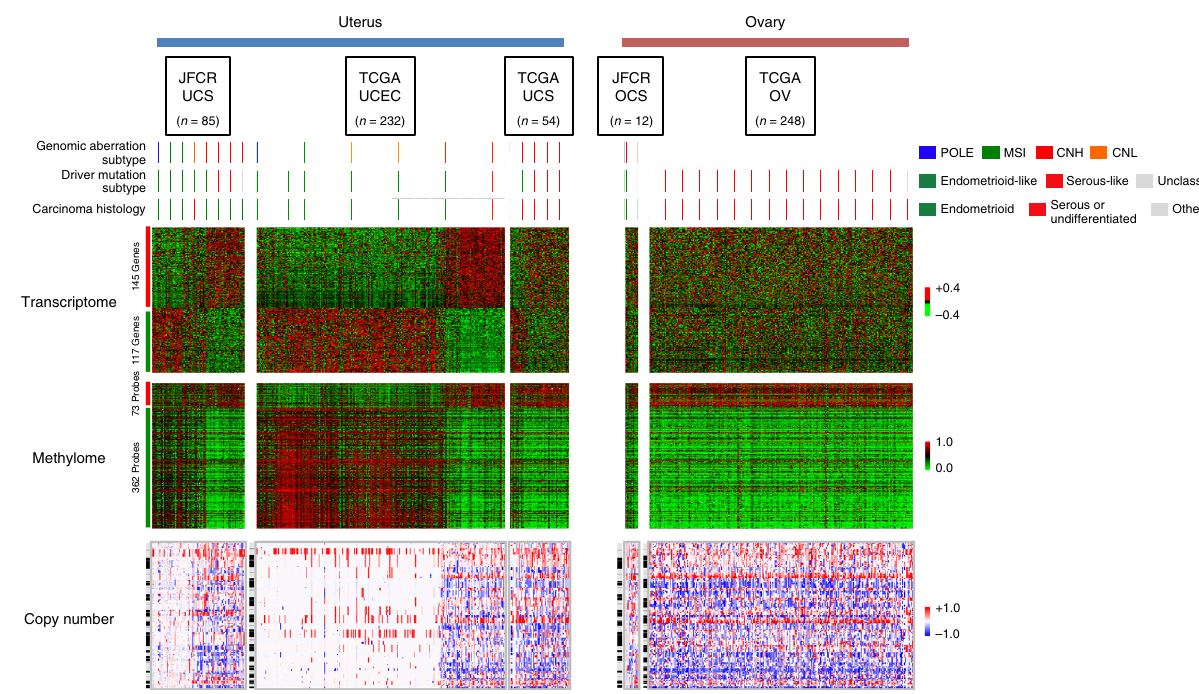
Fig. 4 Genomic aberration subtypes in the transcriptome, DNA methylome, and copy number data derived from uterine and ovarian cancers. Heatmaps for gene expression (upper panel; red and green color indicate high and low expression), CpG methylation (middle panel; red and green color indicate hyper- and hypo- methylation of the CpG site) and aberrant copy number segments (lower panel; red and blue color indicate gain and loss of segments in copy number) are shown. For the transcriptome or DNA methylome, serous (red line) vs. endometrioid (green line) signatures were generated using the uterine corpus endometrial carcinoma datasets in The Cancer Genome Atlas repository (TCGA UCEC n = 232) and applied to uterine and ovarian carcinosarcoma (UCS and OCS) datasets from the JFCR (Japanese Foundation for Cancer Research), TCGA (JFCR UCS n = 85, TCGA UCS n = 54, and JFCR OCS n = 12), and from TCGA high-grade serous ovarian cancer (TCGA OV n = 248). Data are presented as heatmaps. The serous vs. endometrioid signatures consisted of 145 and 117 genes for the transcriptome and 73 and 362 probes for the DNA methylome. For copy number data, the heatmaps show abnormal segments detected by EXCAVATOR and GISTIC in chromosomal order. Genomic aberration subtypes (POLE, blue; MSI, green; CNH, red; and CNL, orange), driver mutation subtypes (endometrioid-like, green; serous-like, red; and unclassi fi ed, gray), and carcinoma histology (endometrioid, green; serous, red; and the other histologies, gray) are presented above the